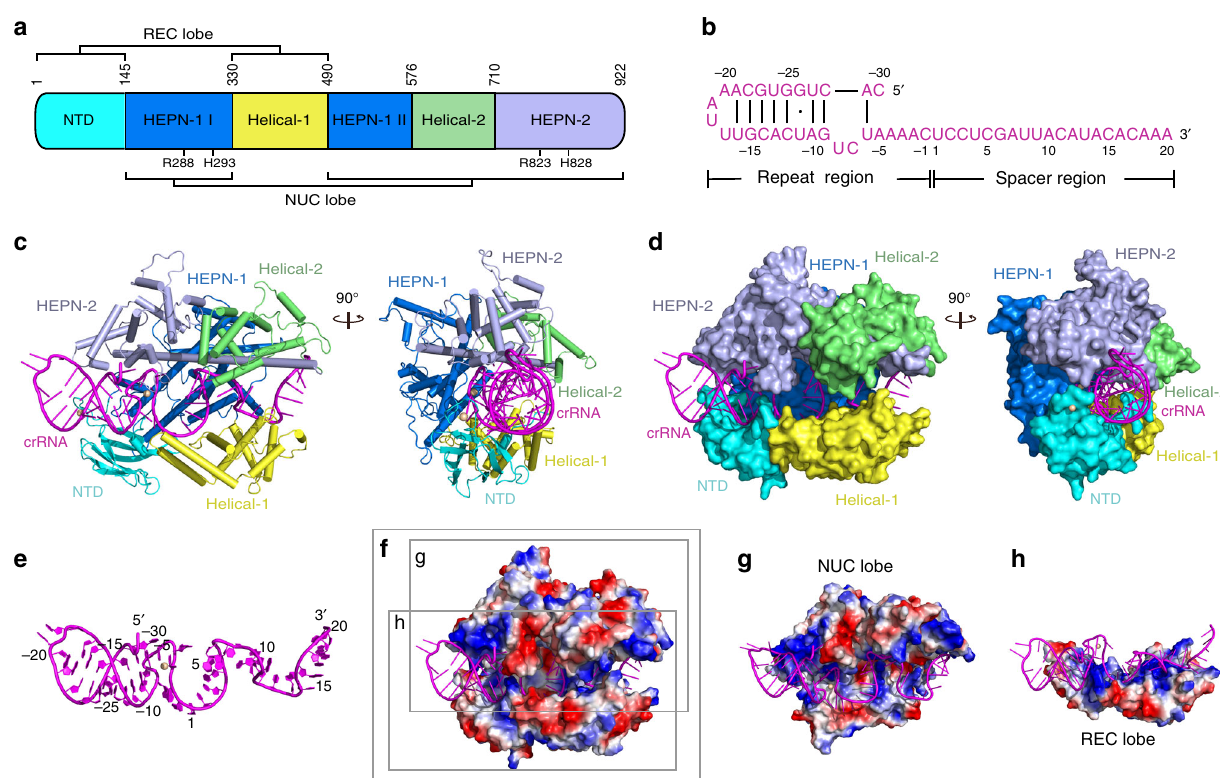
Fig. 1 Overall structure of the UrCas13d-crRNA binary complex. a Domain organization of UrCas13d. Catalytic residues of the R-X 4 -H motifs within two HEPN domains are labeled. b Schematic representation of the crRNA secondary structure. Bars between nucleotide pairs represent Watson-Crick base pairs and dot represents wobble G-U base pair. c Overall structure of the UrCas13d-crRNA binary complex shown in two different orientations, color-coded as de fi ned in a and b . d Surface representations of the UrCas13d-crRNA binary complex shown the same views as in ( c ). e Structure of crRNA in the binary complex. Mg 2 + is colored in wheat. f Electrostatic potential surface of the crRNA binding channel in the binary complex. Red, white and blue indicate negative, neutral and positive electrostatic potential surfaces, respectively. g Electrostatic potential surface of the NUC lobe in complex with crRNA. h Electrostatic potential surface of the REC lobe in complex with